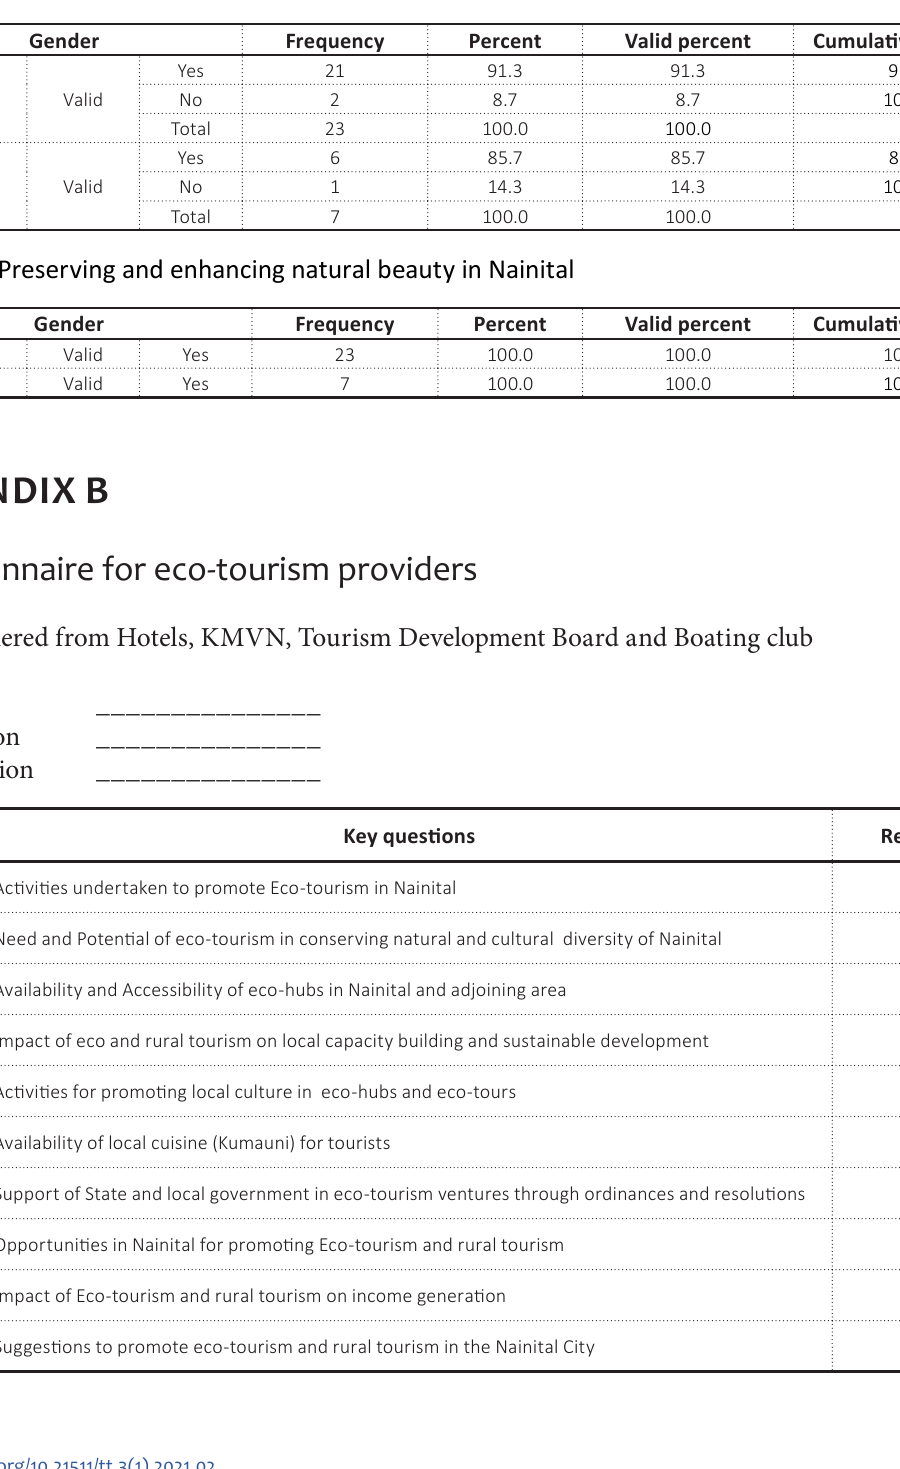
Table A5. Disposing waste material in the proper place in Nainital